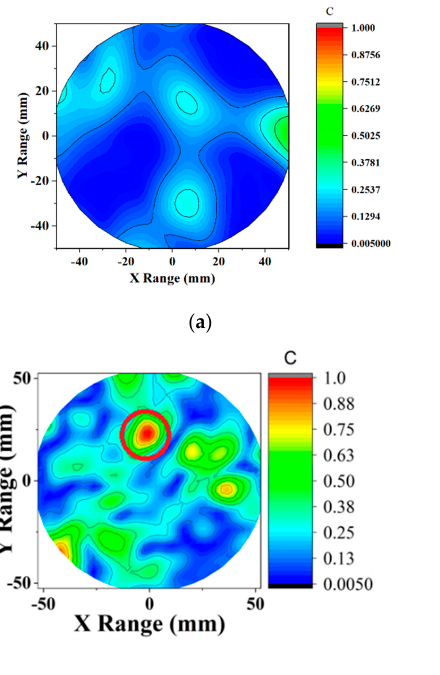
(1600) and applying